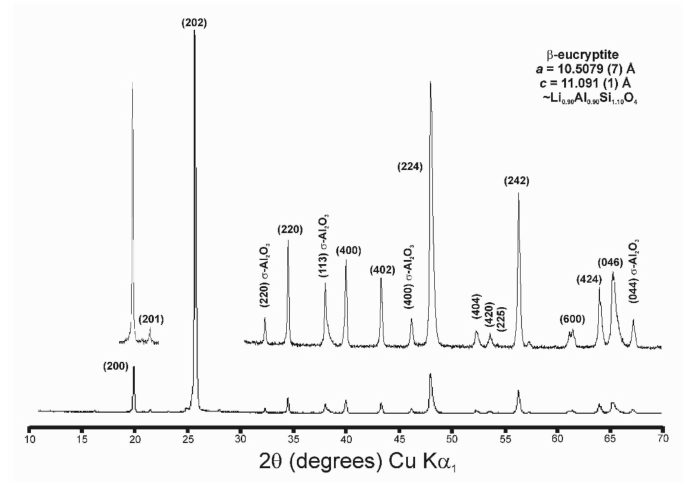
Figure A5. Powder XRD pattern of β -eucryptite synthesized at 1200 ◦ C and 1 atm, nominal x = 0 (real x = 0.1 from the loss of lithium and crystallization of σ -Al 2 O 3 ) having approximate compo- sition as Li 0 . 90 Al 0 . 90 Si 1 . 10 O 4 , and Rietveld refinement cell parameters as a = b = 10.5079 (7) Å, c = 11.091 (1) Å, α = 90 ◦ , β = 90 ◦ , and γ = 120 ◦ , with (hkl) from the P 6 4 22 model of Pillars and Peacor (1973) [12]. The specimen is very similar to file CC 22010 in ICSD database, with a = b = 10.5058 (6) Å, c = 10.9526 (7) Å, α = β = 90 ◦ , and γ = 120 ◦ . Peaks from σ -Al 2 O 3 are from file CC 69213 in ICSD database, corresponding to gamma alumina file 29-00636 in PDF database. The (201) diffraction was clear for x ≤ 0.5 at T ≥ 1000 ◦ C.